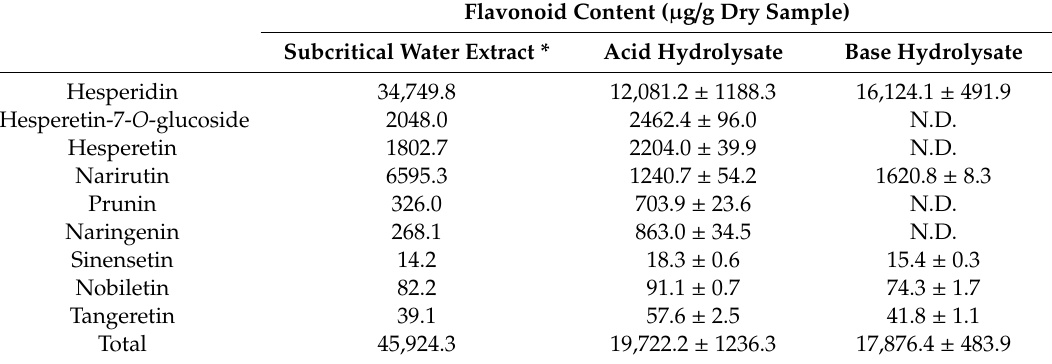
Table 2. Comparison of flavonoids in subcritical water extract and acid and base hydrolysates processed from C. unshiu